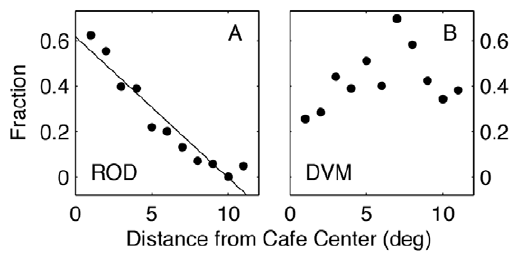
Figure 6. Spatial dependence of white shark ‘ROD’ (A) and ‘DVM’ (B) behavior in the Cafe´. The regression shows that for ‘ROD’ the fraction of time (days) white sharks were engaged in ‘ROD’ declined steadily and linearly as a function of distance from the center of the Cafe´ region. In contrast no clear spatial relationship was evident for ‘DVM’.